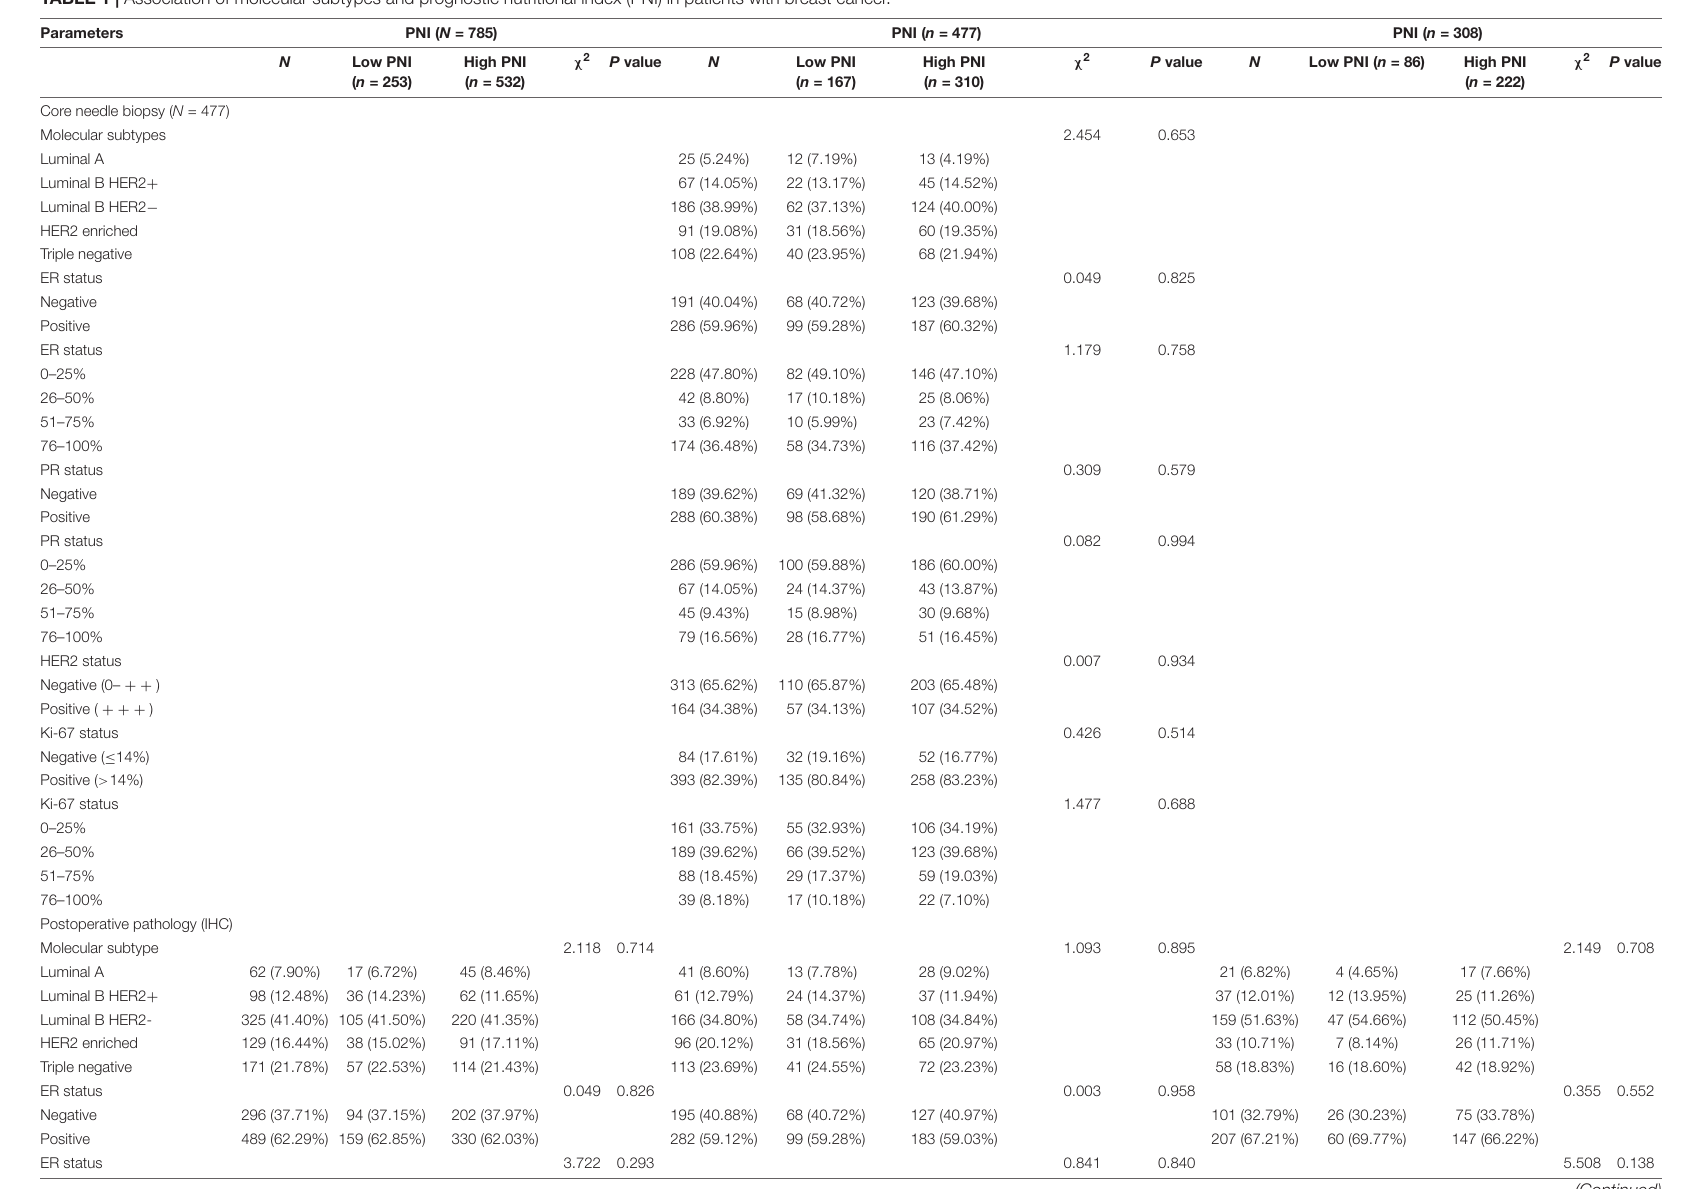
TABLE 1 | Association of molecular subtypes and prognostic nutritional index (PNI) in patients with breast cancer.